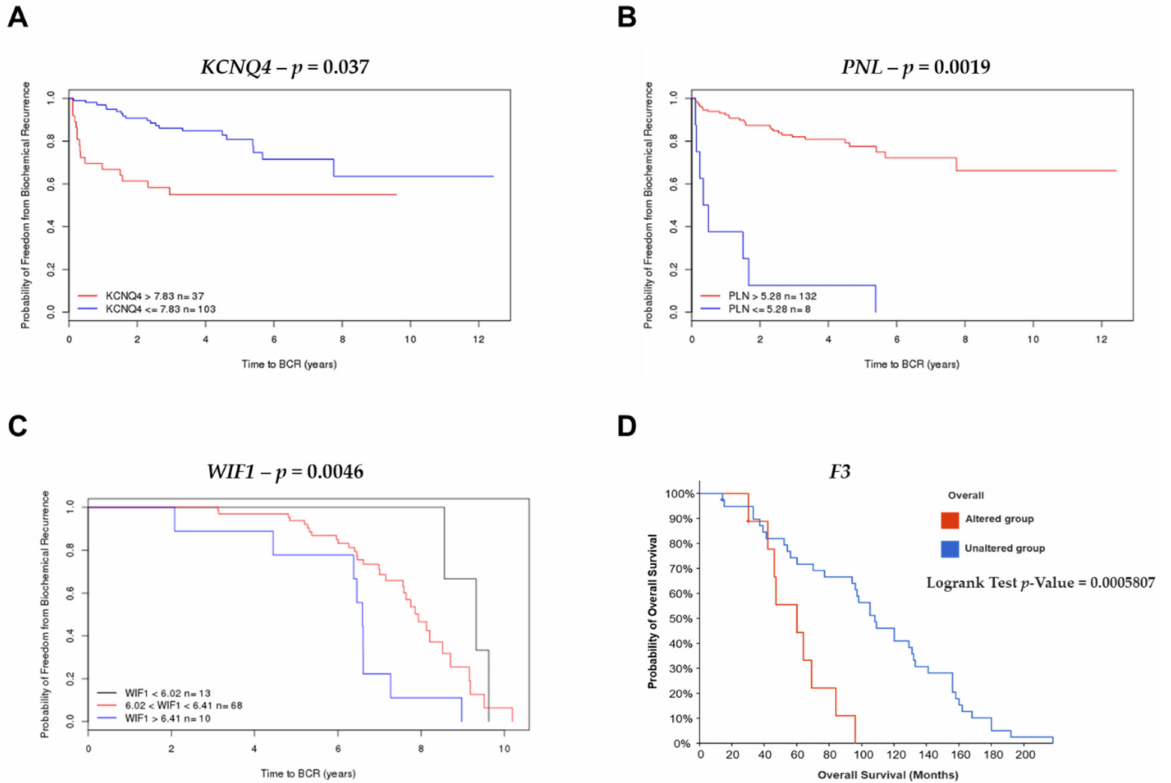
Figure 7. Kaplan–Meier curves displaying the probability of freedom from BRC and overall survival of PCa with (red) or without (blue) Differentially Expressed Genes (DEGs) overexpression. Analyzed by the Cambridge Carcinoma of the Prostate App (CamcAPP) (https://bioinformatics.cruk.cam.ac. uk/apps/camcAPP/) [41] (accessed on 21 December 2021) and the cBioPortal for Cancer Genomics database (https://www.cbioportal.org/) (accessed on 21 December 2021) [42,43] from an integrative study. ( A )—Kaplan–Meier curve with the probability of freedom from biochemical recurrence of PCa with (red) or without (blue) KCNQ4 overexpression with cut-off = 7.83 from the MSKCC study [8]; the difference was statistically significant, p = 0.037. ( B )—Kaplan–Meier curve with the probability of freedom from biochemical recurrence of PCa with (red) or without (blue) PLN overexpression with cut-off = 5.28 from the MSKCC study [8]; the difference was statistically significant, p = 0.0019. ( C )—Kaplan–Meier curve with the probability of freedom from biochemical recurrence of PCa with WIF1 expression with cut-off <6.02 (black line), WIF1 gene expression with cut-off <6.41 (red line), and patients with WIF1 gene expression with cut-off >6.41 (blue line) ( p = 0.0046) from the Stockholm study [44]; the difference was statistically significant, p = 0.0046. ( D )—Kaplan–Meier curve with the probability of overall survival of PCa patients with (red) or without (blue) F3 alteration from the metastatic prostate adenocarcinoma (MCTP, Nature 2012) study [45]; the difference was statistically significant, p =